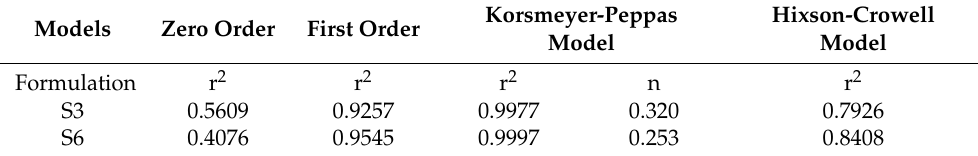
Table 2. Fitted mathematical models for formulated IBU nanoconjugate hydrogels S3 and S6. Models